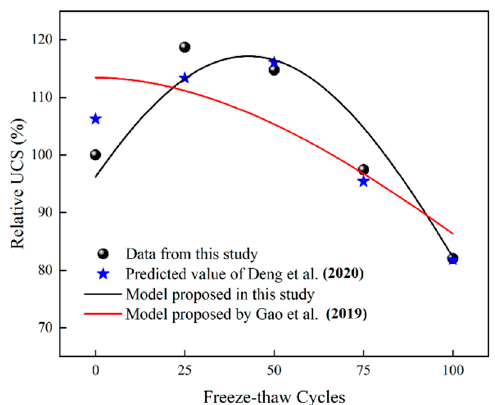
(20) Table 5. Summary of prediction models. Model max D Figure 11. Variation of